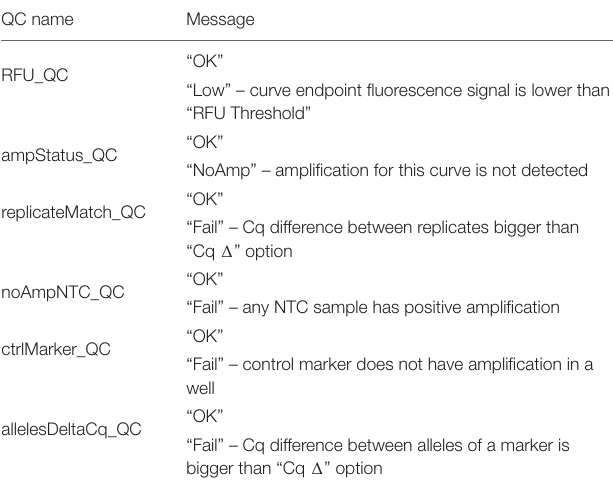
TABLE 1 | Quality check codes